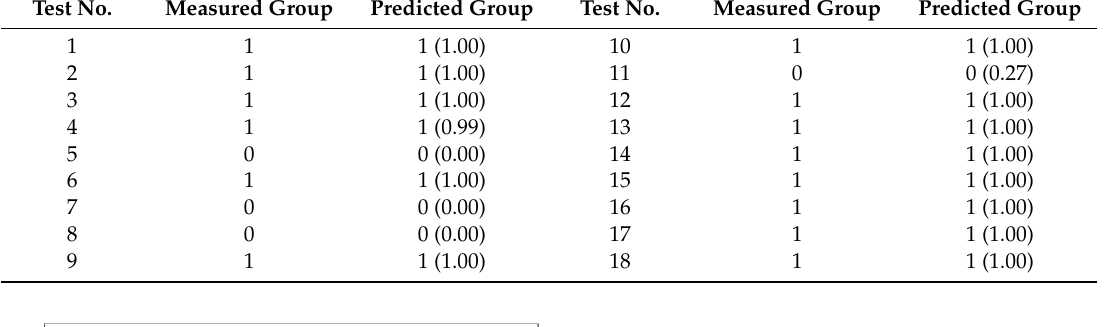
Table 10. Results of group discriminant for crack susceptibility according to SVM. Test No.